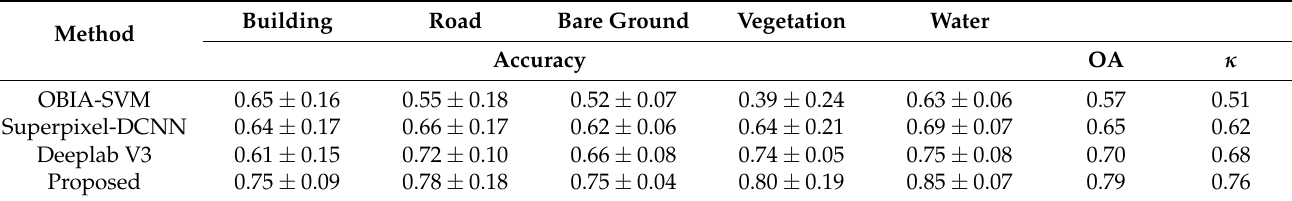
Table 3. Classification results on GF.